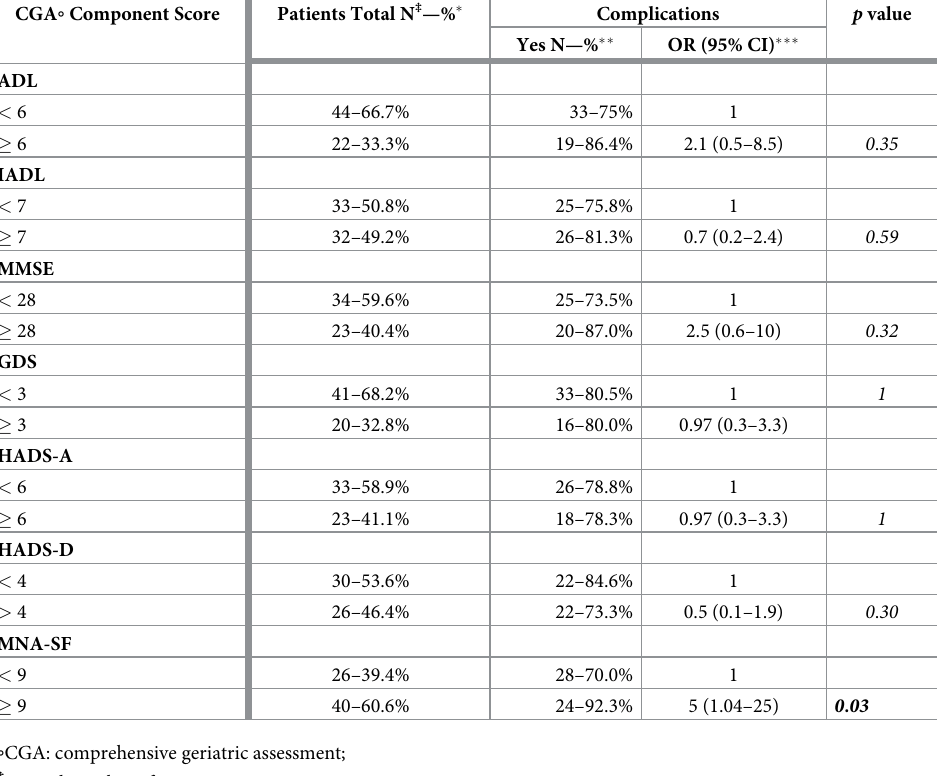
Table 3. Univariate analysis for each CGA component score, as predictors of postoperative